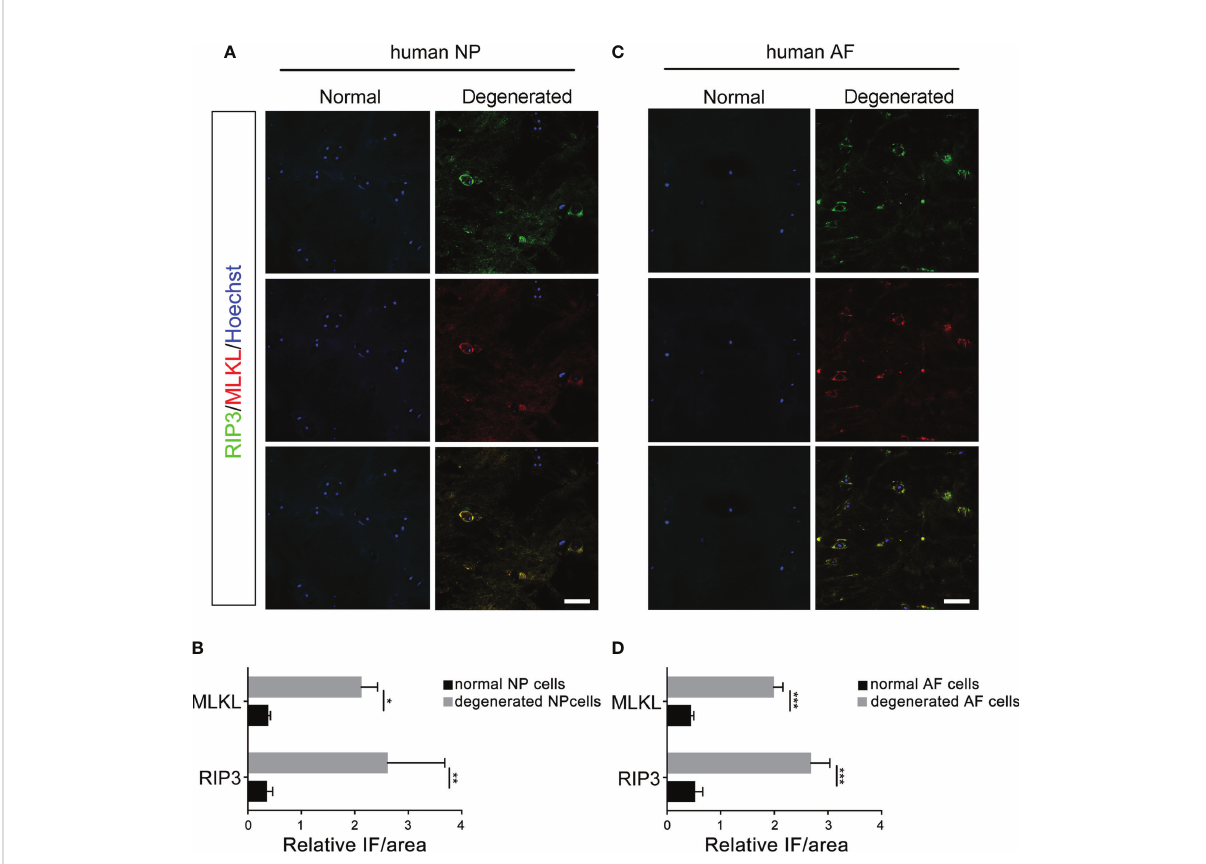
FIGURE 1 Analysis of necroptosis of NP cells and AF cells in the normal and degenerated disc. (A) Double-staining of RIP3 with MLKL was performed to detect necroptotic NP cells in normal and degenerated disc. (B) Relative IF intensity of MLKL and RIP3 in NP cells. (C) Double-staining of RIP3 with MLKL was performed to detect necroptotic AF cells in disc. (D) Relative IF intensity of MLKL and RIP3 in AF cells. *P < 0.05, **P < 0.01, ***P < 0.001. N = 6. Bars = 50 m